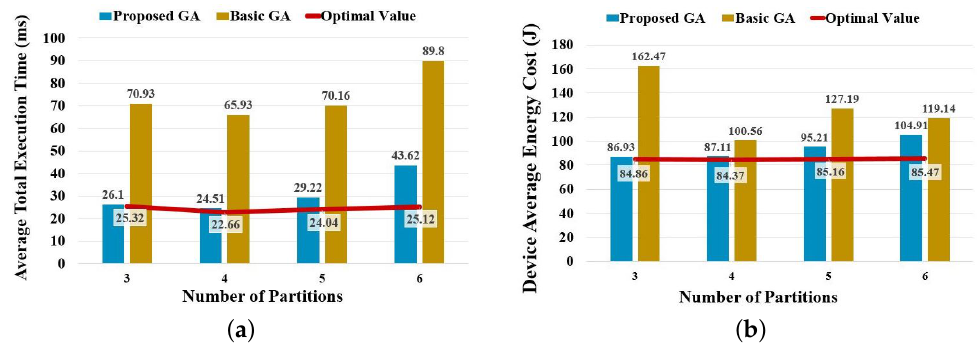
Figure 6. Performance comparison on partitioning B-AlexNet by considering partitioning and deploying simultaneously. ( a ) Comparison on average total execution time. ( b ) Comparison on device-average energy cost.